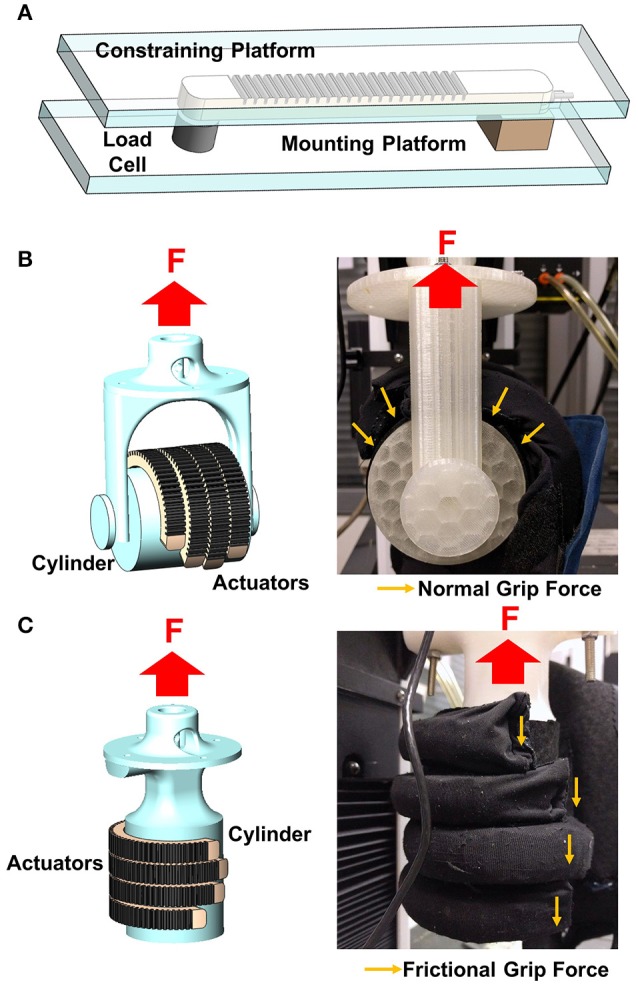
Schematic of the force measurement system for (A) blocked tip force, (B) normal grip force, and (C) frictional grip force measurement.